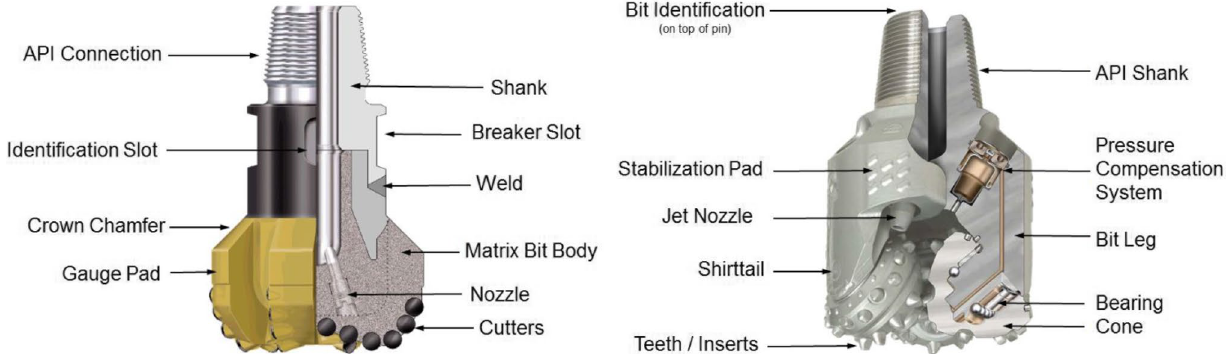
Fig. 4 Main features of PDC and roller cone bits used in Bn-1 (Karadzhova 2014)